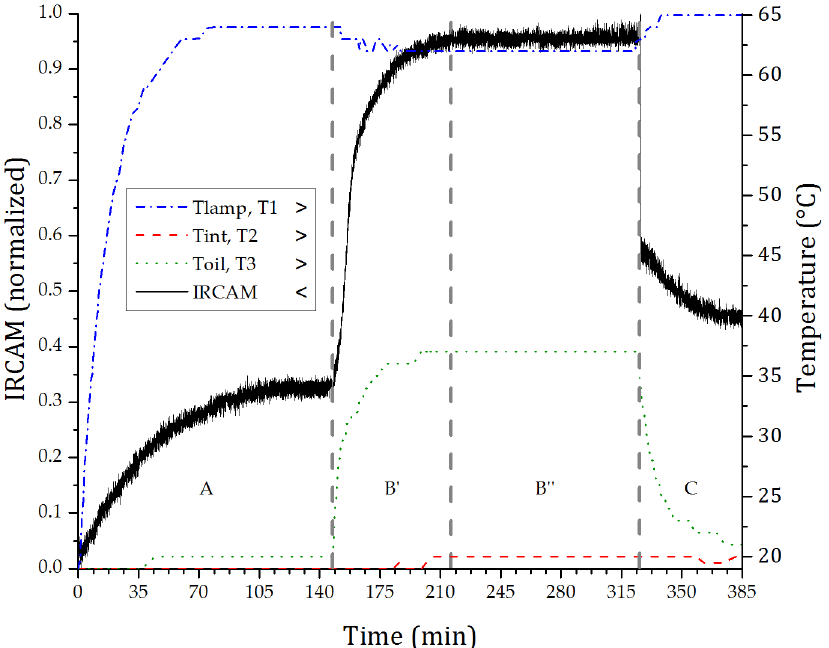
Figure 2. Optical response of the IR detector in relation to the heating of the crude oil sample due to the incidence of the IR radiation source.